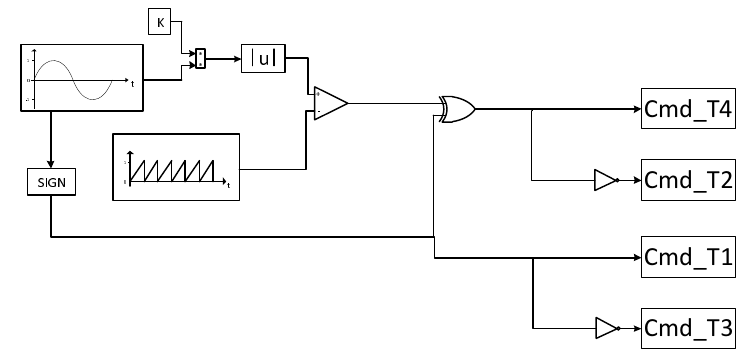
Figure 2. Basic single-phase CSI control. c (cid:13) 2016 IEEE [12].